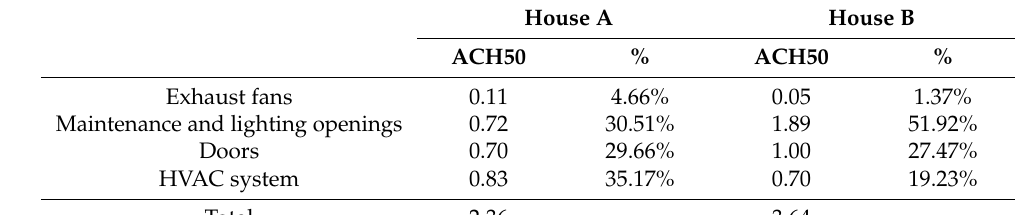
Table 5. The contribution of tested components to the total air leakage.